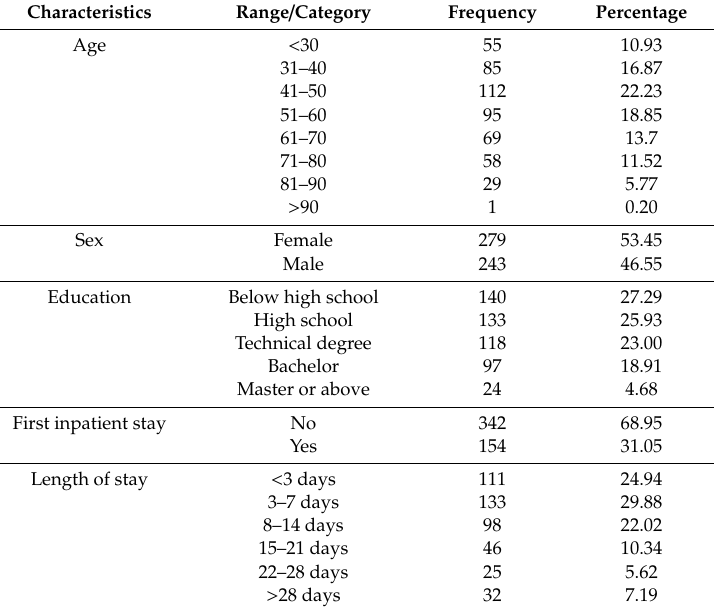
Table 2. Sociodemographic characteristics of the patient